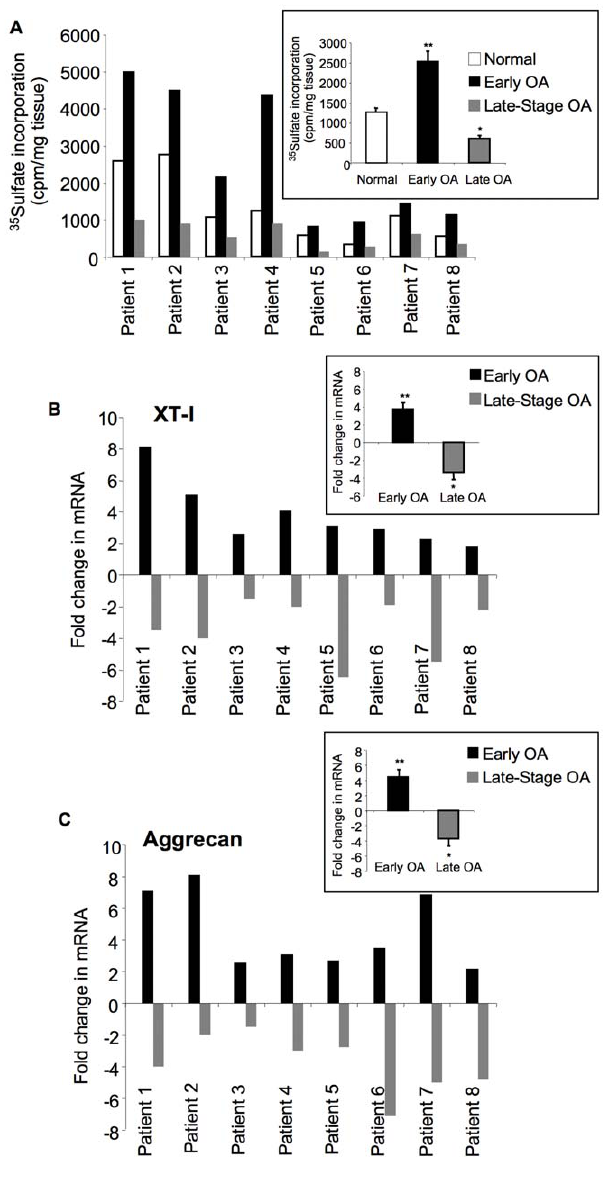
Figure 2. Analysis of GAG synthesis and expression of XT-I and aggrecan genes. (A) GAG synthesis analysis in cartilage from ‘‘normal’’, early OA and late-stage OA areas for each patient studied by 35 S-sulfate incorporation. Insert shows the mean of GAG synthesis rate values corresponding to different areas of cartilage sample from all patients. Values are mean 6 SEM of 3 experiments per parameter, per joint, per patient. (B) and (C) Analyses of the expression of XT-I and aggrecan genes in cartilage from normal, early OA and late-stage OA areas for each patient. The expression level of the genes was analyzed by qPCR. Measurements were normalized to the control ‘‘normal’’. Inserts in (B) and (C) show the mean of XT-I and aggrecan gene expression level values corresponding to different areas of cartilage sample from all patients. Values are mean 6 SD of 3 experiments per parameter, per joint, per patient. **significantly ( P , 0.01) higher than normal and late groups; 1 significantly ( P , 0.05) higher than normal and late groups; *significantly ( P , 0.05) lower than